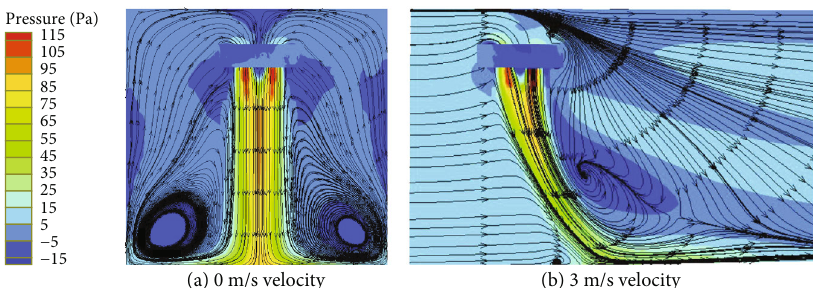
Figure 7: The streamlines of fl ow fi eld at di ff erent free stream